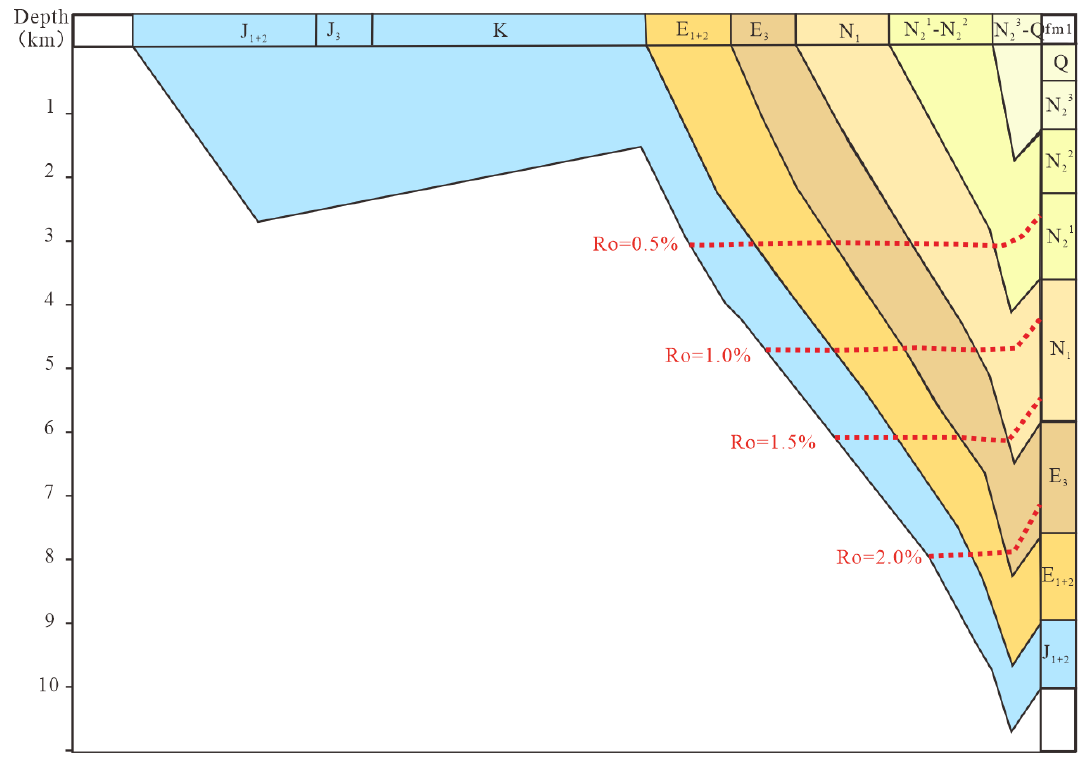
Figure 19. Burial history of the Lower Jurassic reservoir in the Niudong area, northern margin of Qaidam Basin, China (modified from [74]).